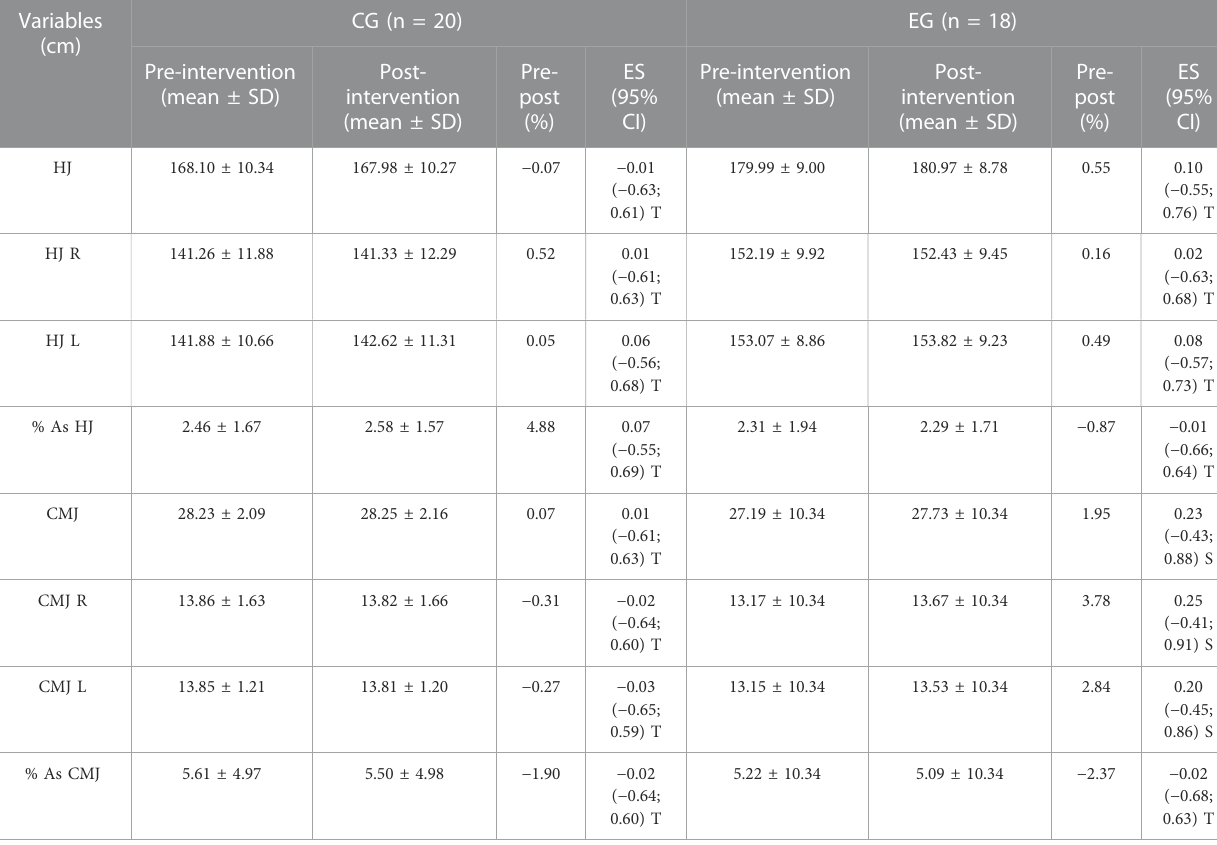
TABLE 2 Results of vertical and horizontal jump variables in control and experimental group.